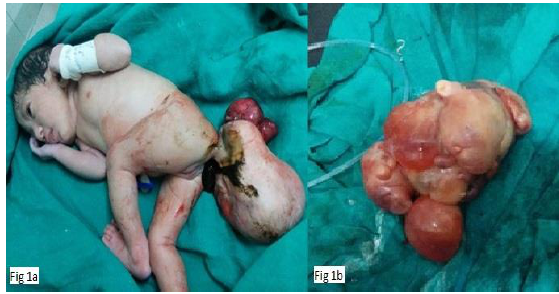
Figure 1: (a) Newborn immediately after delivery with attached sacral parasite (b) Gross morphology of globular mass which was delivered along with the